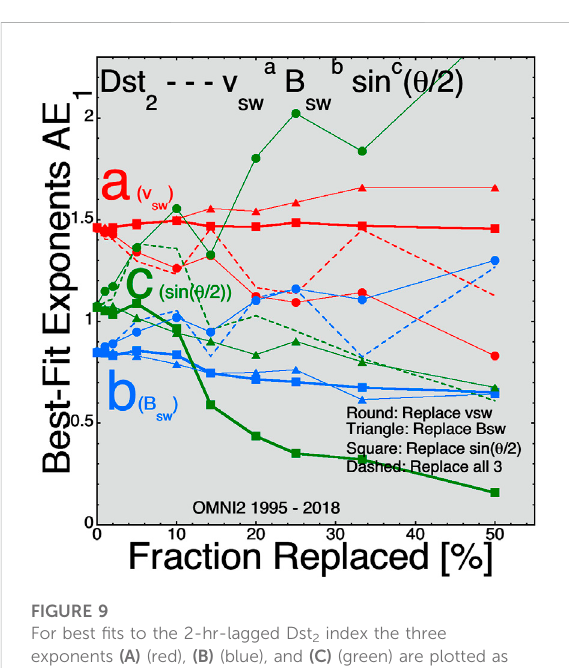
FIGURE 9 For best fi ts to the 2-hr-lagged Dst 2 index the three exponents (A) (red), (B) (blue), and (C) (green) are plotted as functions of the fraction of time-series values replaced for three solar-wind